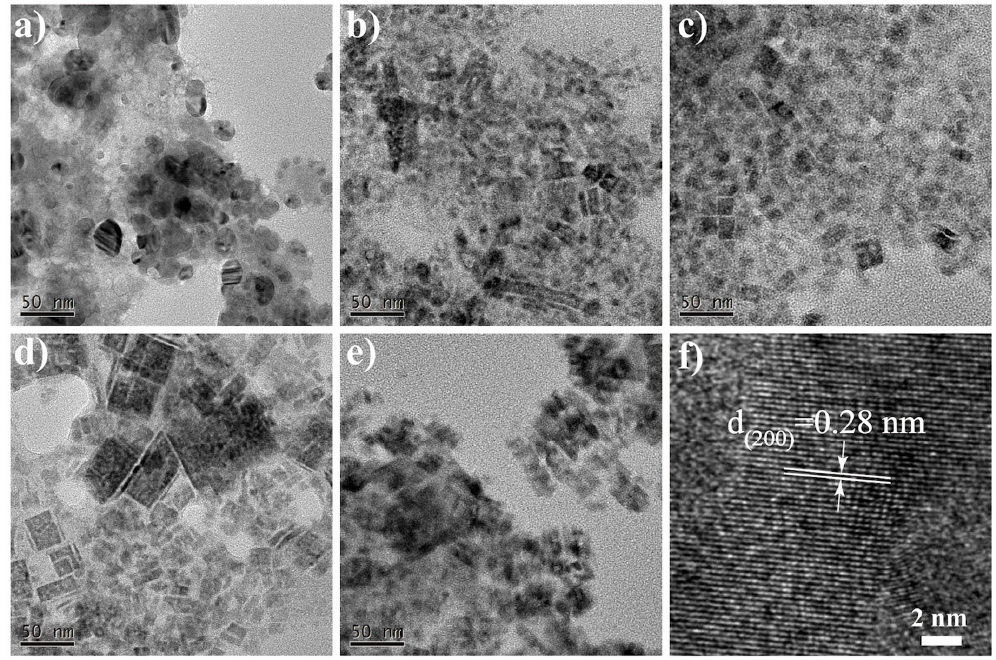
Figure 2. TEM images of Mn 2+ -doped CH 3 NH 3 PbCl 3 PNCs doped with different Mn 2+ concentrations. ( a ) 0 at. % Mn 2+ , ( b ) 25 at. % Mn 2+ , ( c ) 50 at. % Mn 2+ , ( d ) 75 at. % Mn 2+ , ( e ) 90 at. % Mn 2+ and ( f ) HRTEM image of 0 at. % Mn 2+